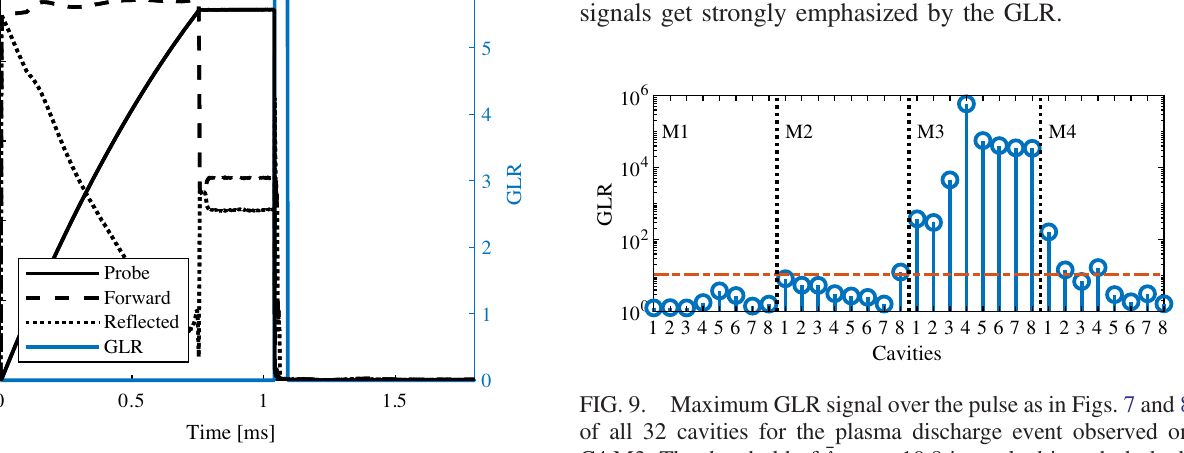
FIG. 7. Field emitter signals for cavity C4.M3.